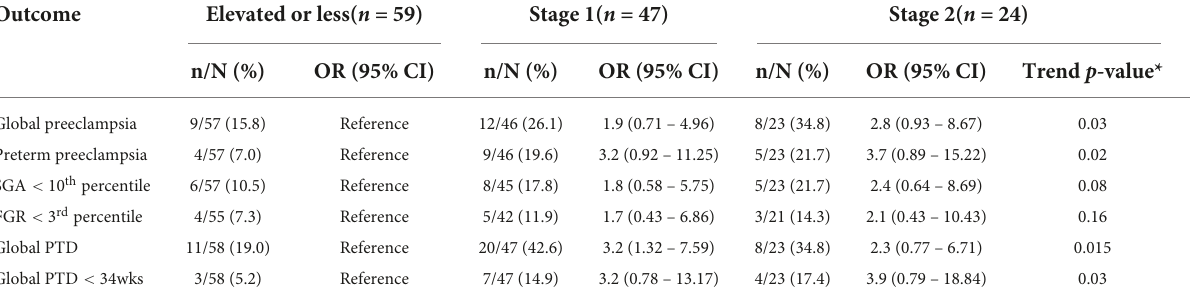
TABLE 2 Odds ratios for perinatal outcomes after univariate logistic regression